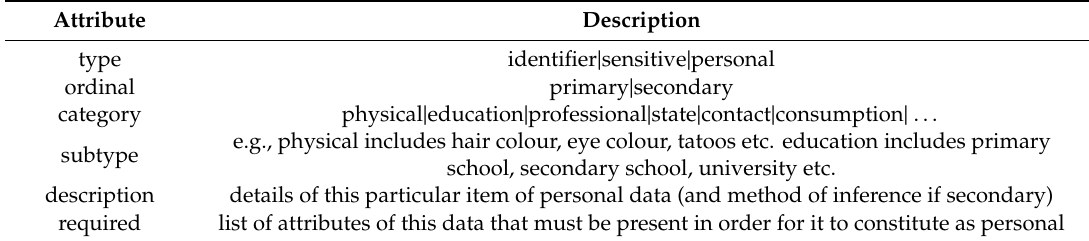
Table 2. Personal data